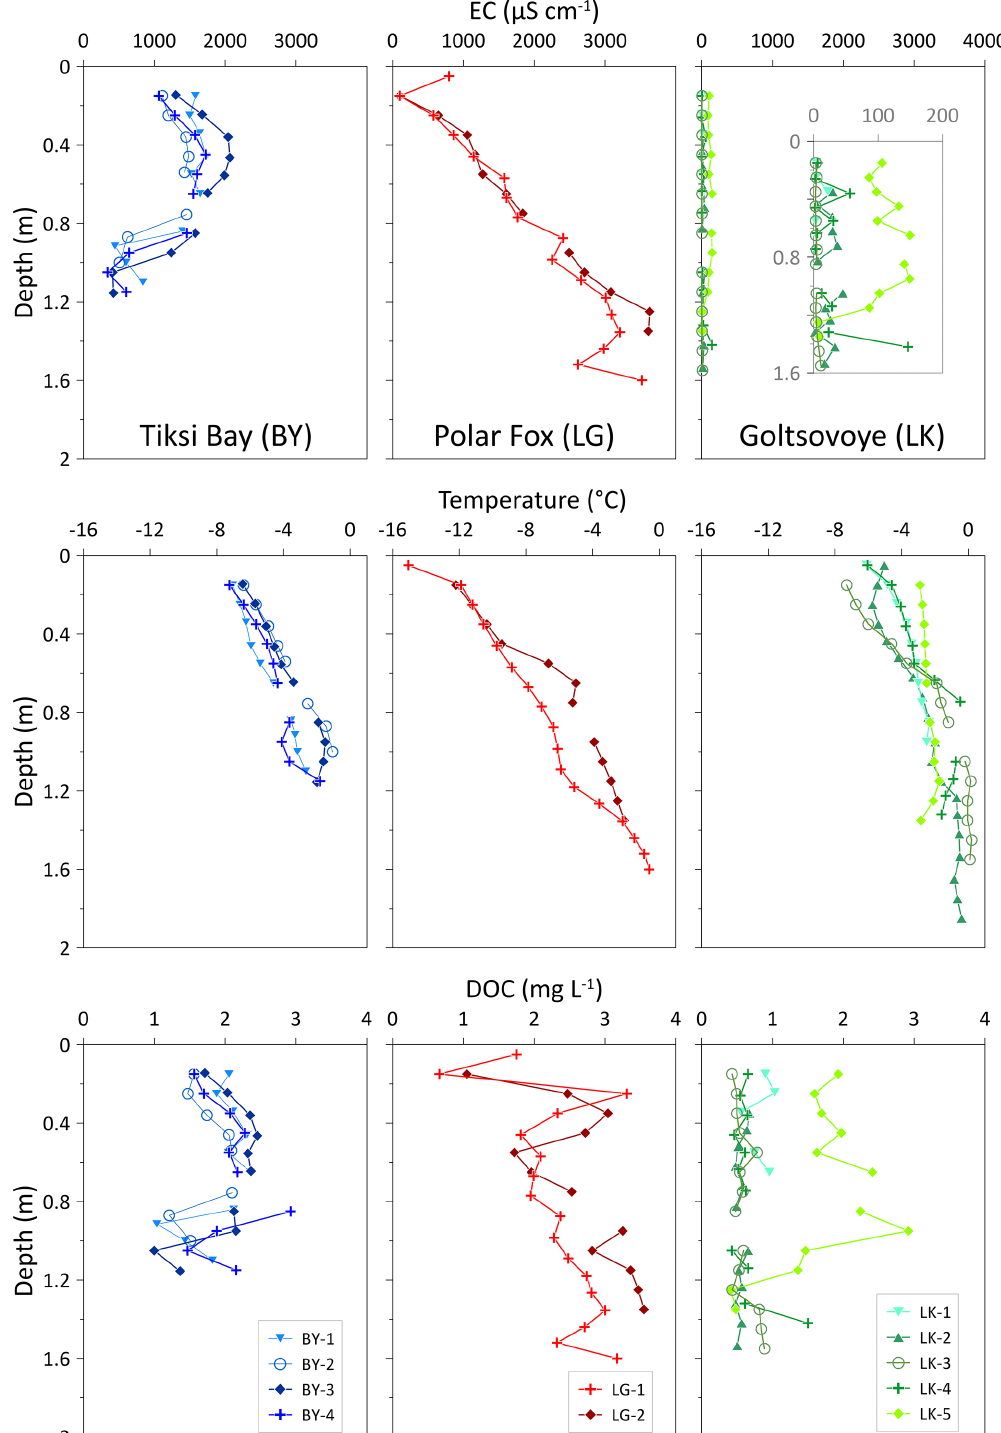
Figure 4. Vertical distribution of the electrical conductivity (EC), temperature, and dissolved organic carbon (DOC) in ice cores with depth.